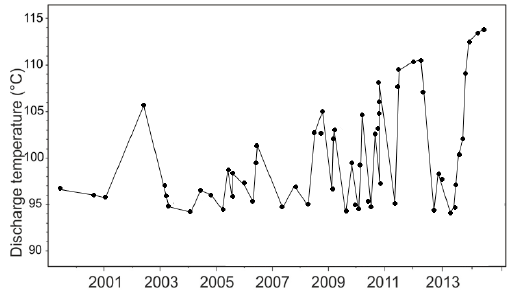
Figure 9. Time series of discharge temperature at Pisciarelli fumarole, eastern to the crater rim of Solfatara (Pozzuoli) (modified after [15]). Data show that temperature variations of tens of degrees can occur at different temporal scales.